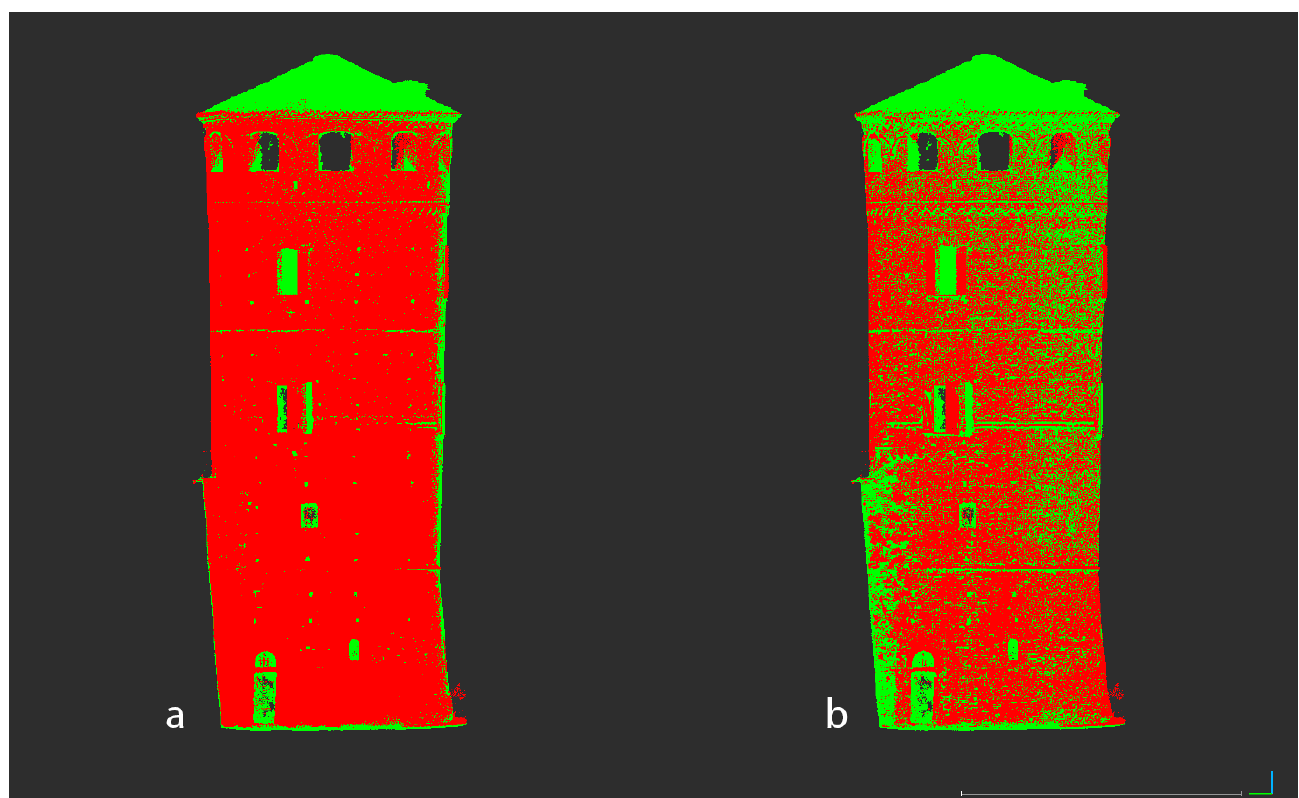
Figure 11. ICP registration and alignment related to P1 data (green—aligned) and SX10 (red—static reference): ( a ) before the alignment; ( b ) after the alignment.